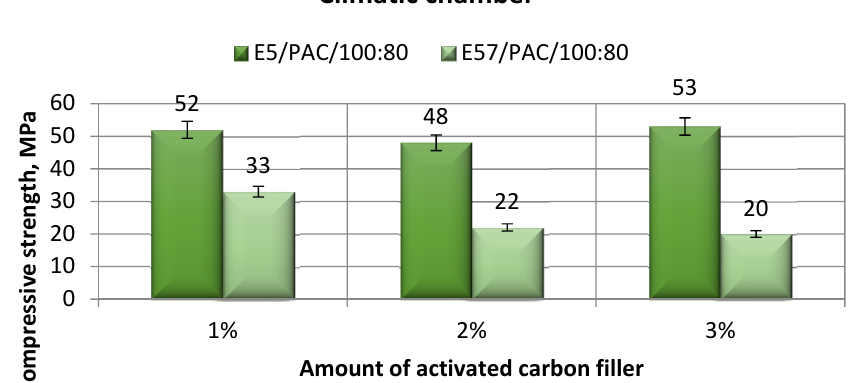
Figure 15. Comparison of the compression modulus between the E5 / PAC / 100:80 and E57 / PAC / 100:80 epoxy specimens modified by the activated carbon filler post-climate chamber aging.